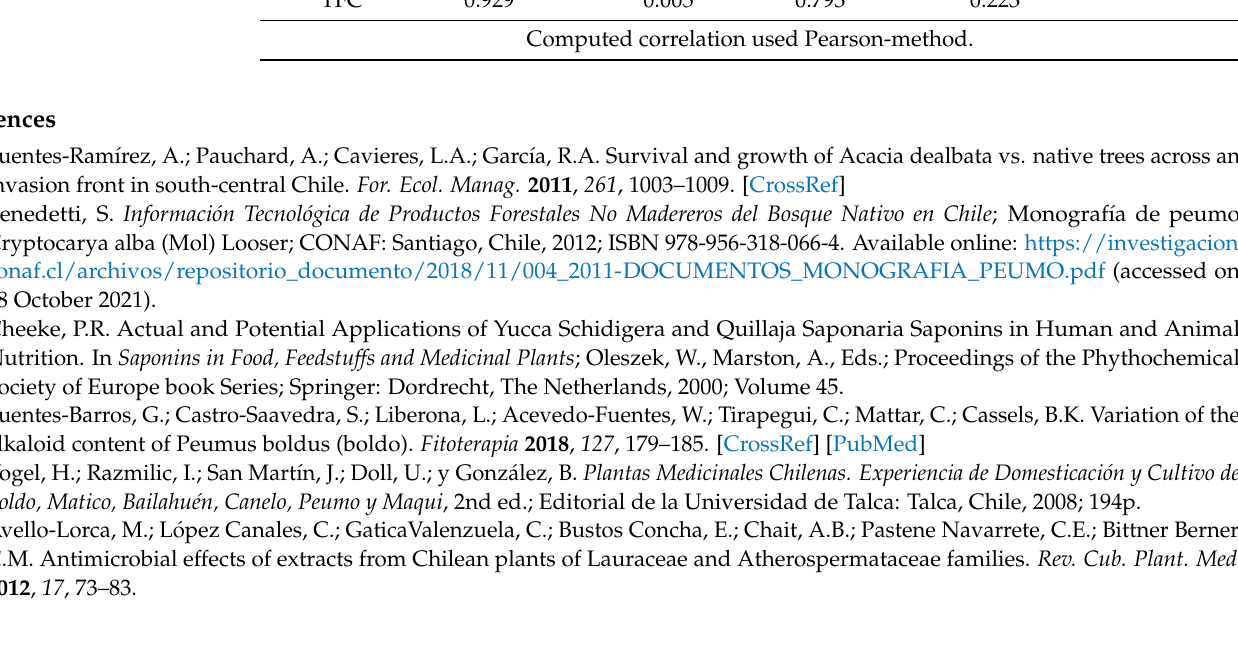
Computed correlation used